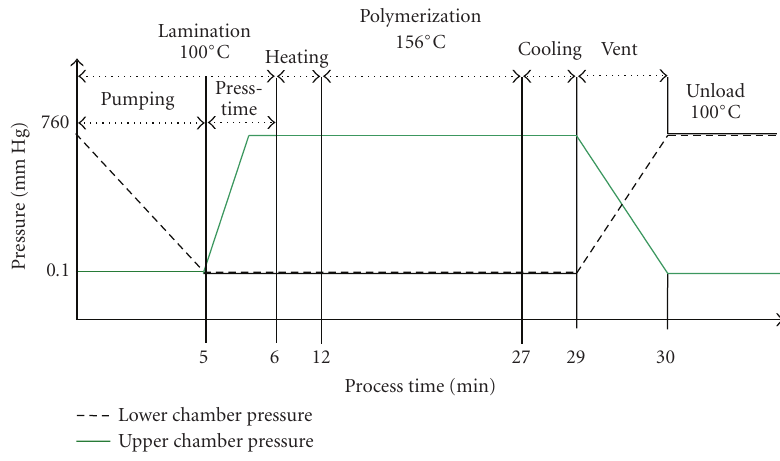
Figure 5: Thermal treatment profile (long cycle) in the laminator.